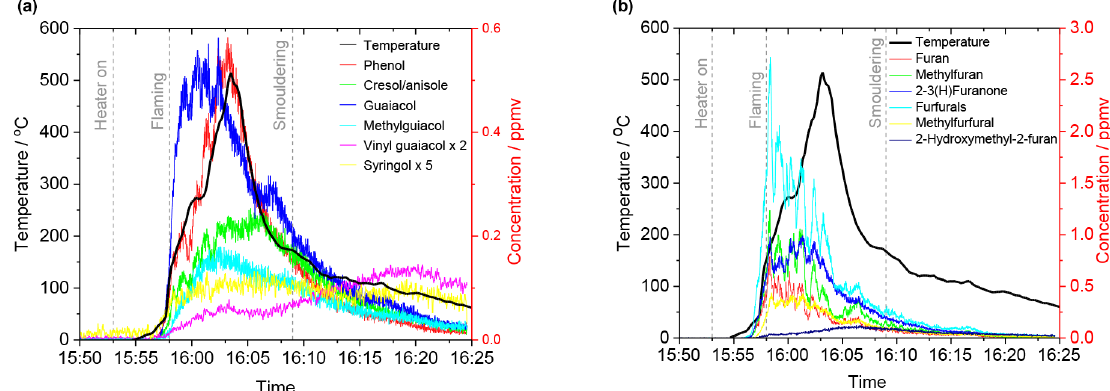
Figure 5. Concentration time series analysis of phenolic and furanic compounds released from burning of Azadirachta indica which released 27.0gkg − 1 of NMVOCs. Temperature corresponds to the increase in temperature above ambient measured in the flame directly above the combustion experiment.